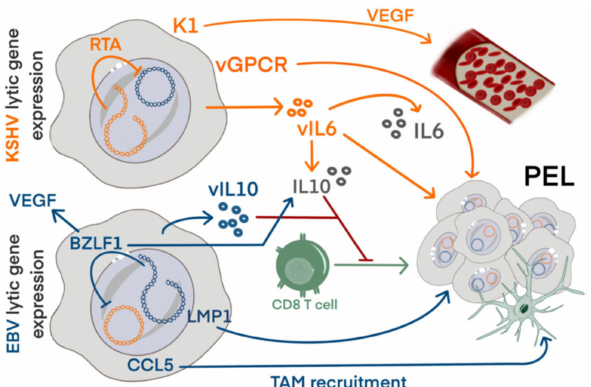
Figure 1. Expression of lytic EBV and KSHV genes can condition the tumor microenvironment. Primary effusion lymphoma (PEL) is associated with KSHV, however 90% of tumors also carry EBV. EBV and KSHV most likely contribute to the tumor environment simultaneously through their lytic gene expression. Lytic KSHV expression contributes through expression of K1, which promotes expression of VEGF and angiogenesis. viral G-protein coupled receptor expression promotes prolif- eration. Expression of the viral cytokine vIL6 promotes production of IL6 and IL10 and increases PEL proliferation. EBV lytic gene expression contributes through CCL5 production that attracts monocytes, which as tumor associated macrophages (TAM) have immune suppressive functions. Expression of viral IL10 can suppress CD8 + T cell